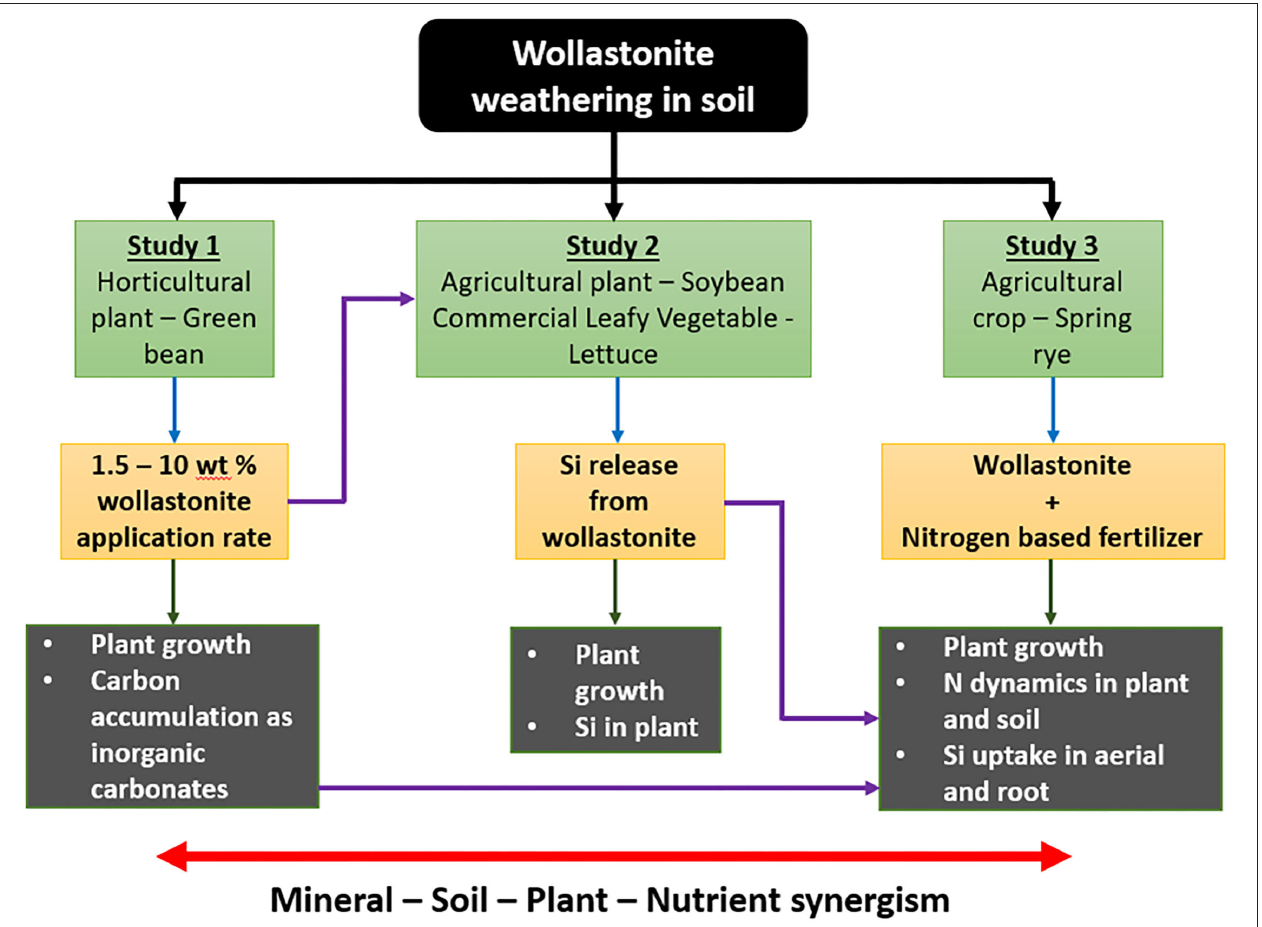
FIGURE 1 | Schematic diagram of the flow of the current study. Study 1 investigated the synergism of wollastonite on plant growth and provided the optimal application rate for Study 2. Study 2 investigated the synergism of silicon release and uptake on improved produce quality. Study 3 further investigated wollastonite amendment and silicon uptake in synergism with nitrogen fertilizer. Study 3 also considered an alternate way of applying wollastonite to soil (as a fertilizer coating), achieving synergism between ease of application, fertilizer efficiency, and crop